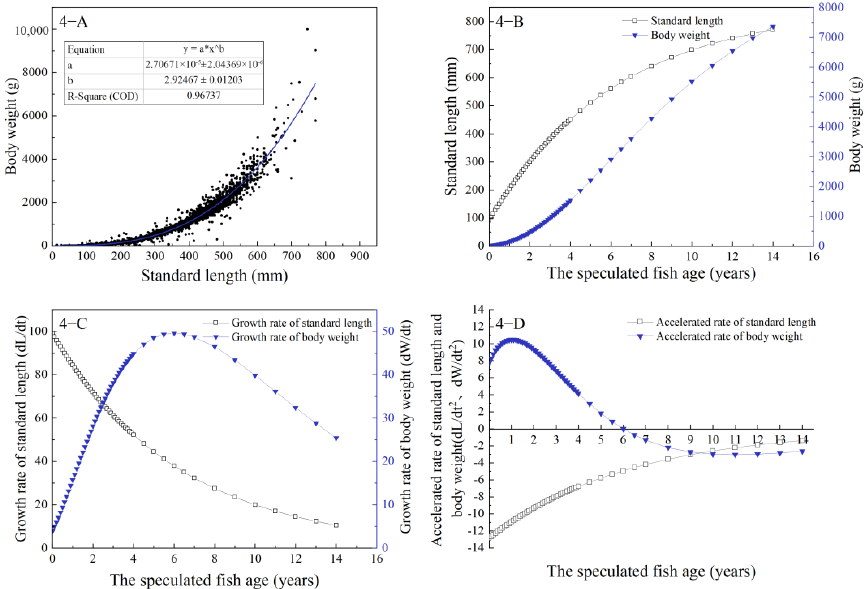
Figure 4. The growth correlation curve between SL and BW of the Silver Carp. ( 4 − A ) is for the growth fitting curve of Silver Carp; ( 4 − B ) is for the SL and BW of Silver Carp; ( 4 − C ) is for the growth rate of SL and BW of Silver Carp; ( 4 − D ) is for the trend of growth rate of SL and BW of Silver